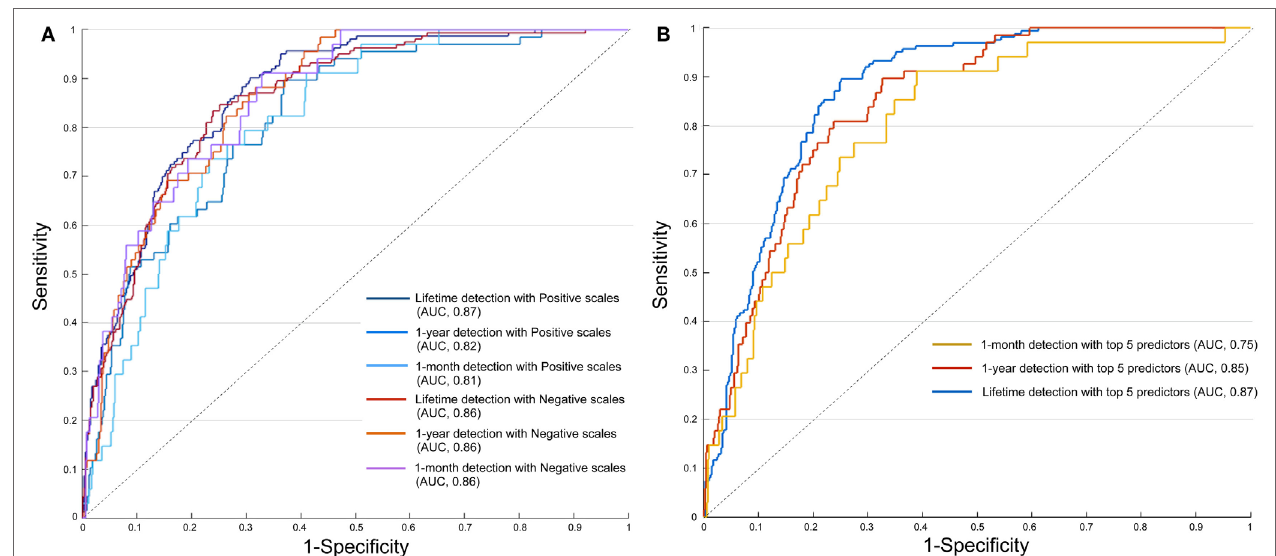
FigUre 3 | Receiver operating characteristics curves and area under the curve (AUC) for classifying suicide attempts with different categories of clinical scales (a) and with the top five ranked variables (B)